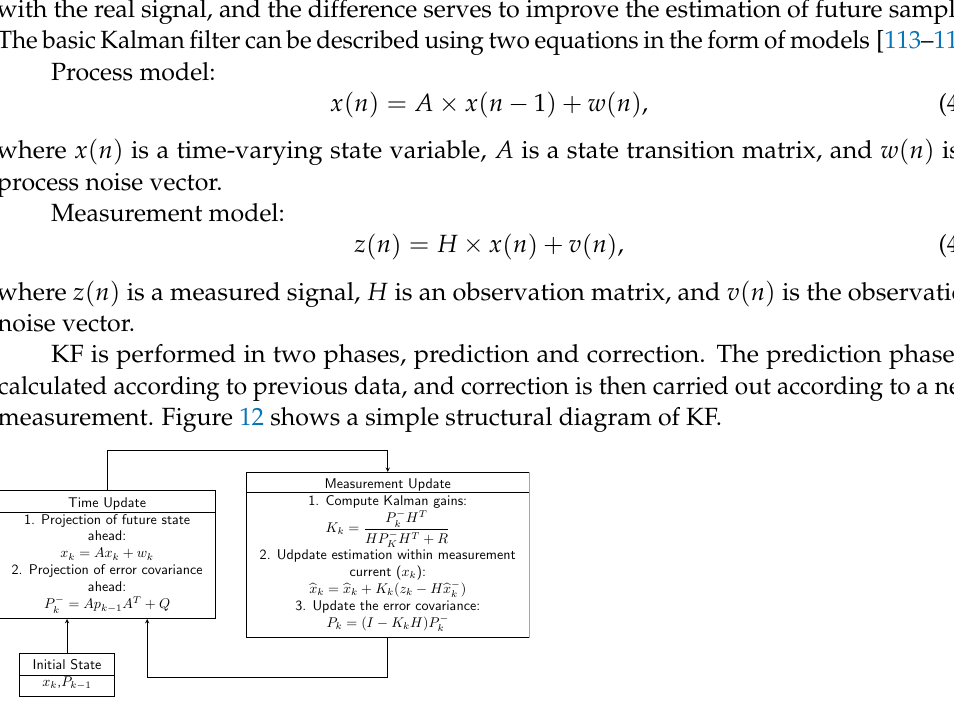
Figure 12. Structure of recursive calculation by prediction–correction